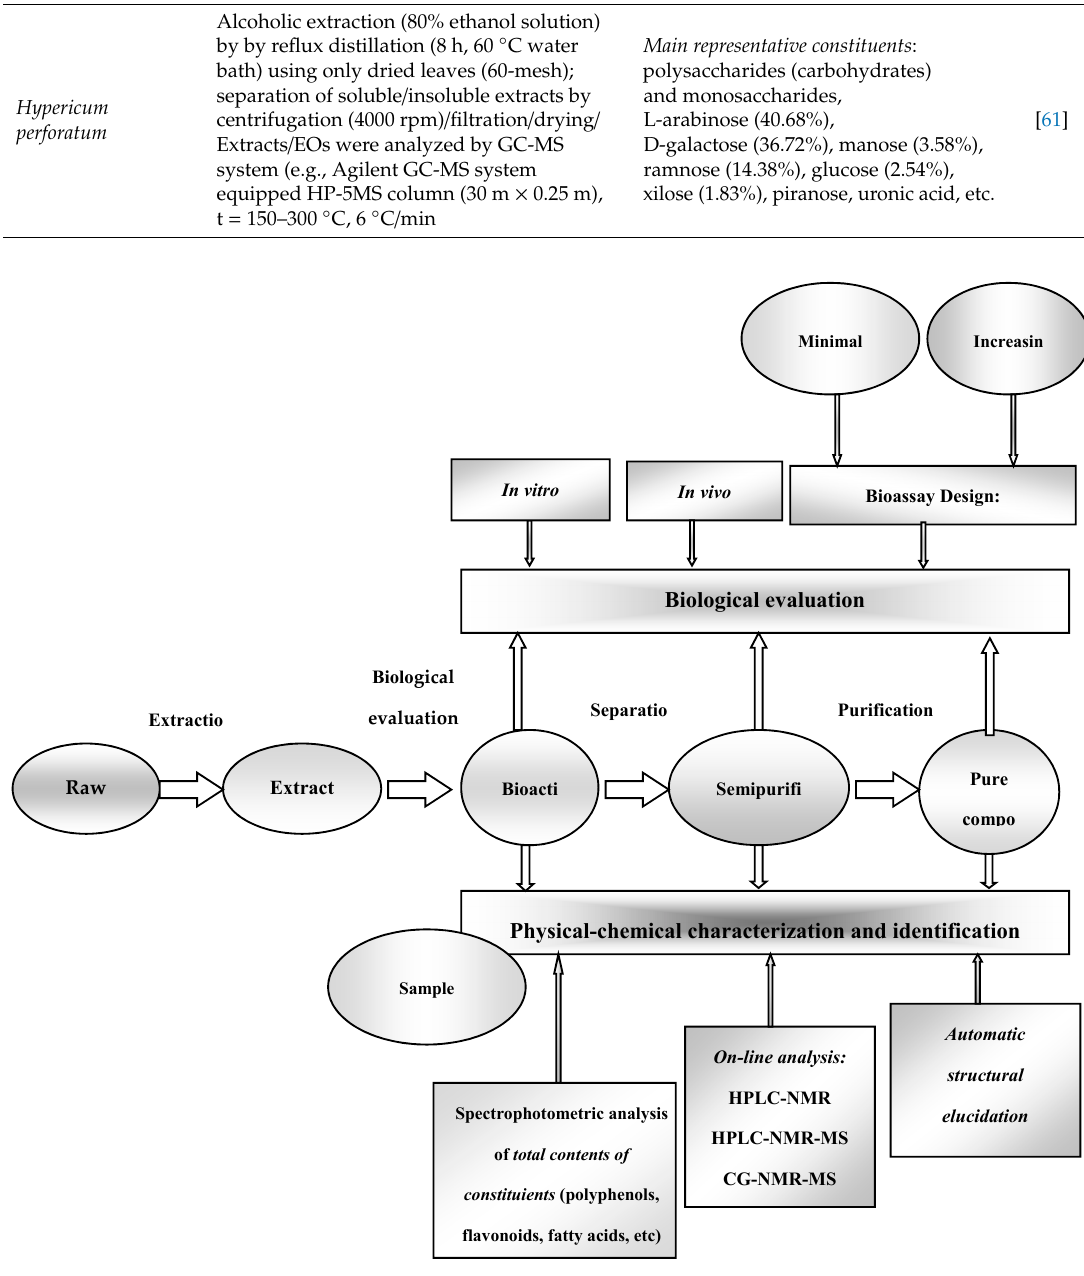
Figure 2. Schematic representation of the extraction of active principles from different plants [32].